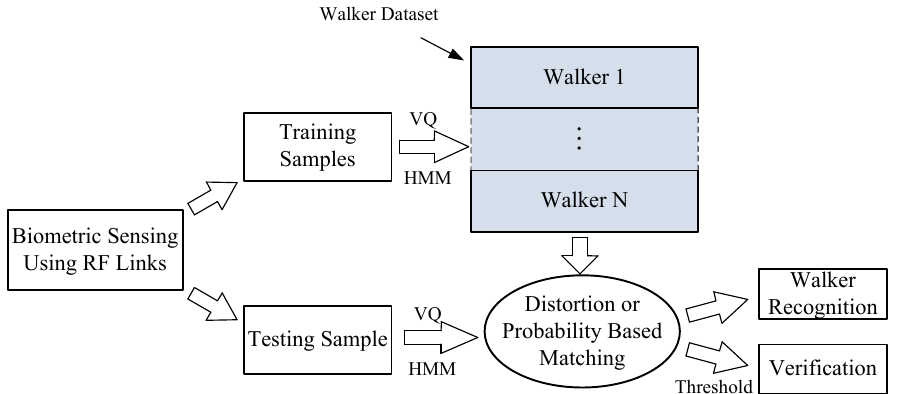
Figure 5. Block diagram of the walker classification process. RF: radio frequency; VQ: vector quantization; HMM: hidden Markov